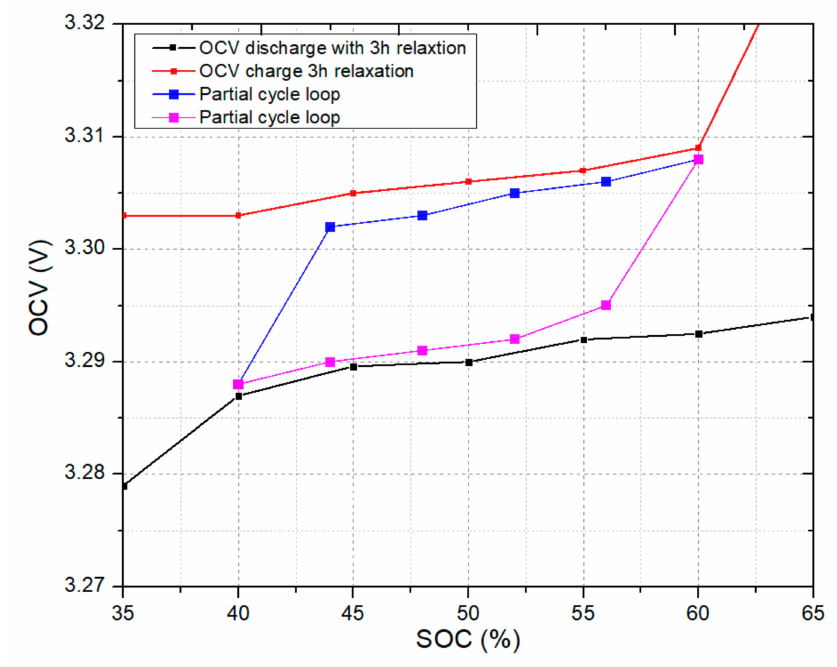
Figure 9. Experimental results of the minor loop hysteresis.